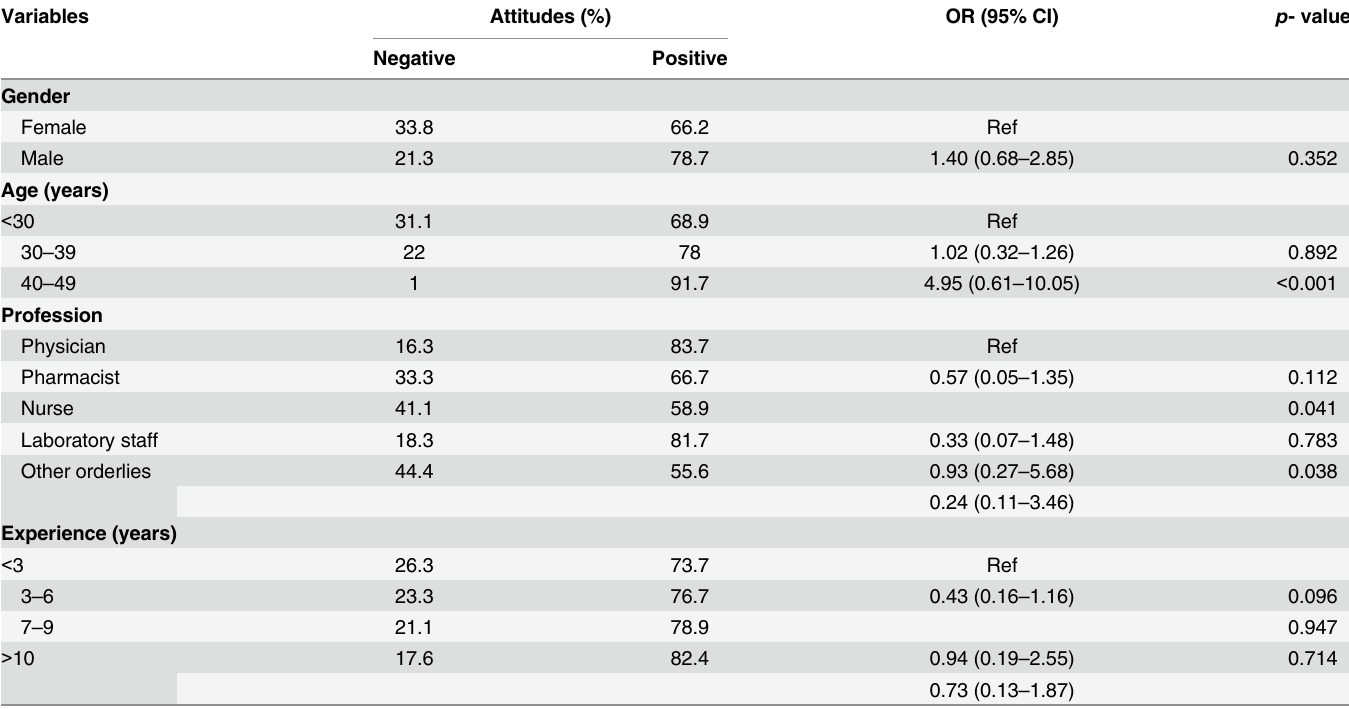
Table 5. Association of demographic variable with the attitudes of participants towards Japanese Encephalitis (N =